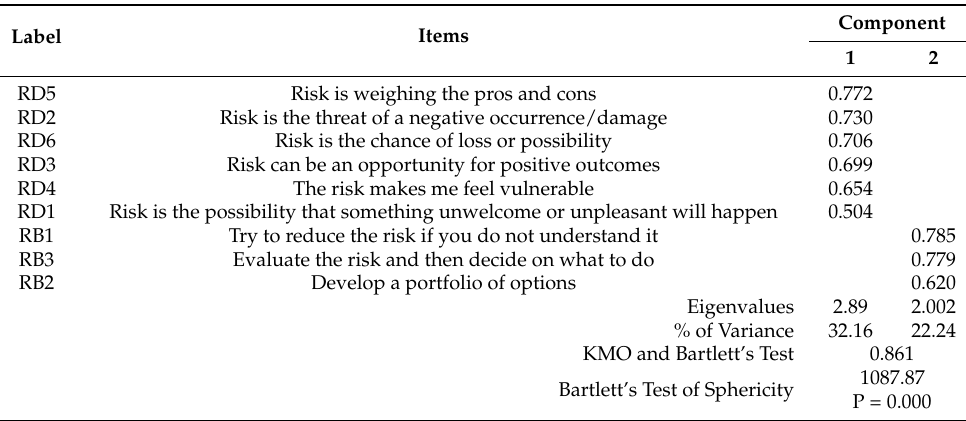
Table 3. Exploratory Factor Analysis Results for the RD and RB Scale.